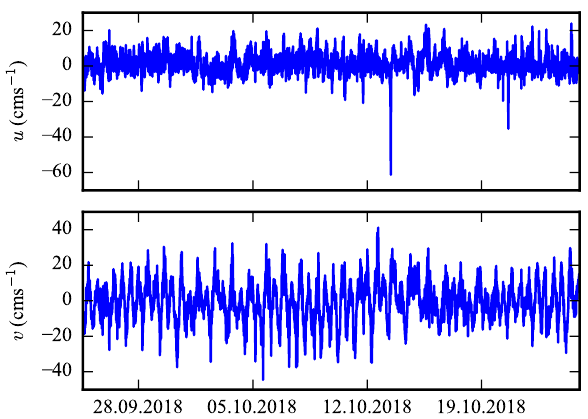
Figure A1. 28 days of near surface easterly and northerly (with respect to true North) velocities components. Measured at the NOAA Cherry Point monitoring station, in units of centimetres per second, and resampled to hourly